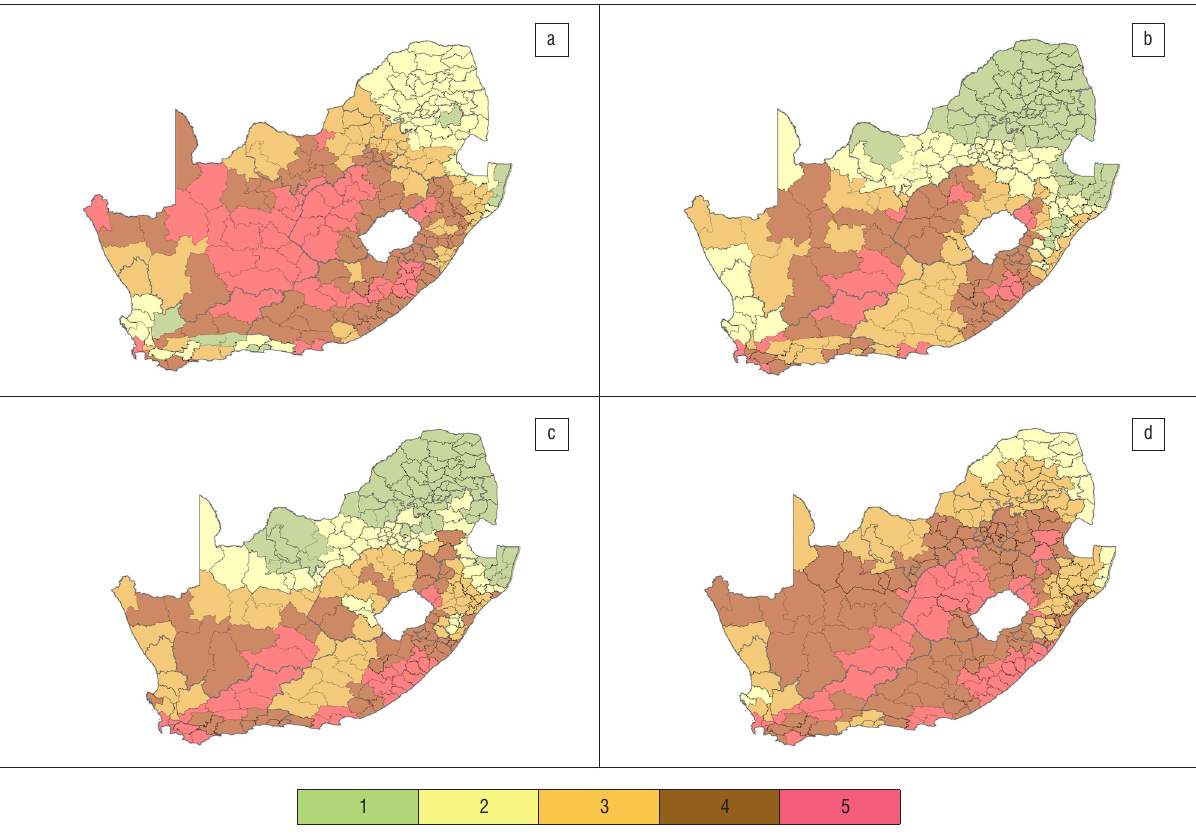
Figure 7: Relative wind hazard per season: (a) Summer (DJF), (b) autumn (MAM), (c) winter (JJA) and (d) spring (SON).